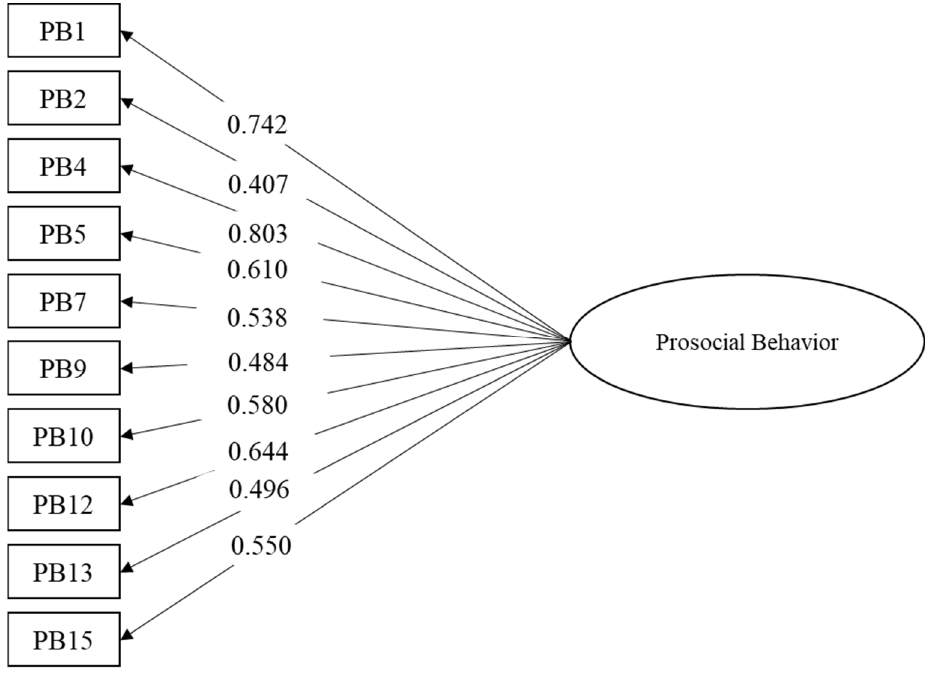
Figure 1. Factorial structure. Note: all the factor loadings are statistically significant p < 0.001.